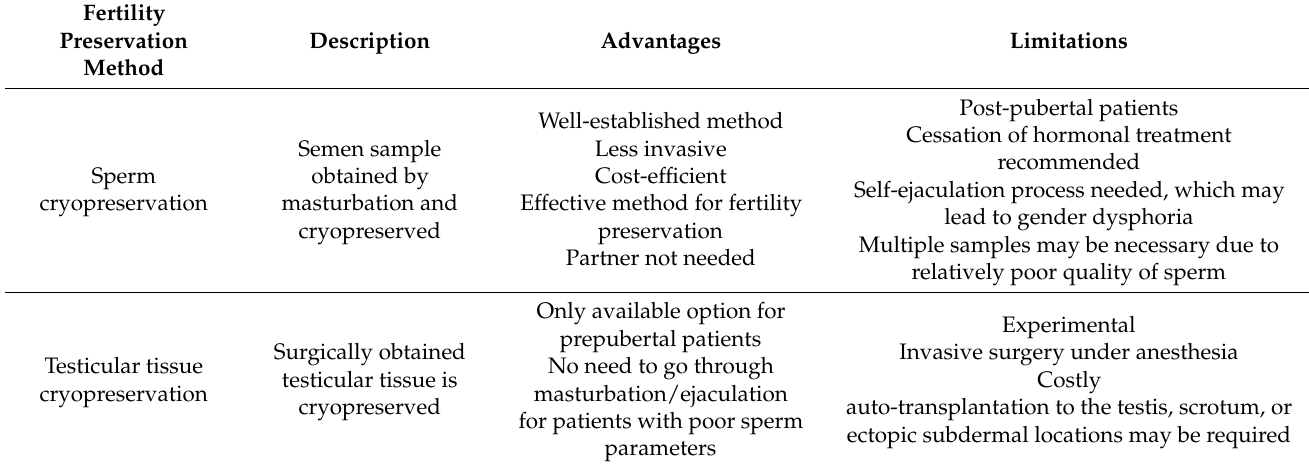
Table 2. Fertility preservation options for